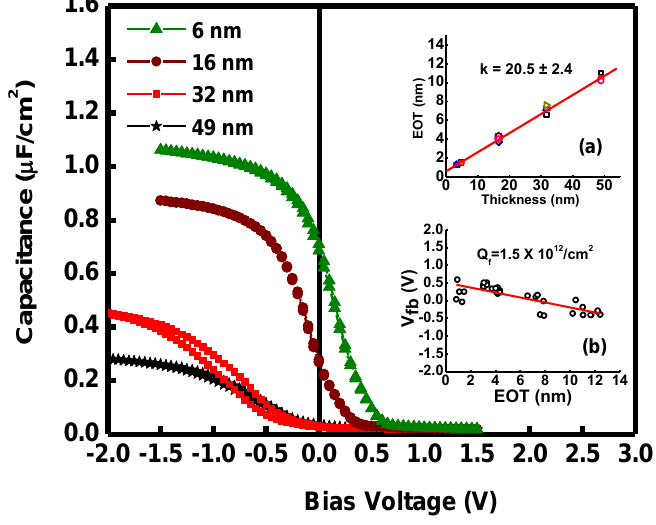
Figure 14. The high-frequency C - V characteristics of Pt/LaGdO varying LaGdO film thicknesses from six to 49 nm. ( a ) The XRR thickness as a function 3 of the equivalent oxide thickness (EOT) of the metal-oxide-silicon (MOS) capacitors to determine the k-value and interfacial layer thickness; ( b ) the flat band voltage versus EOT plots to extract the fixed charges. Reprinted with permission from [17]. Copyright 2013 AIP Publishing